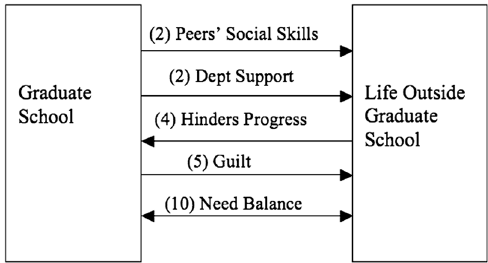
FIG. 1. Female voluntary qualitative response rate